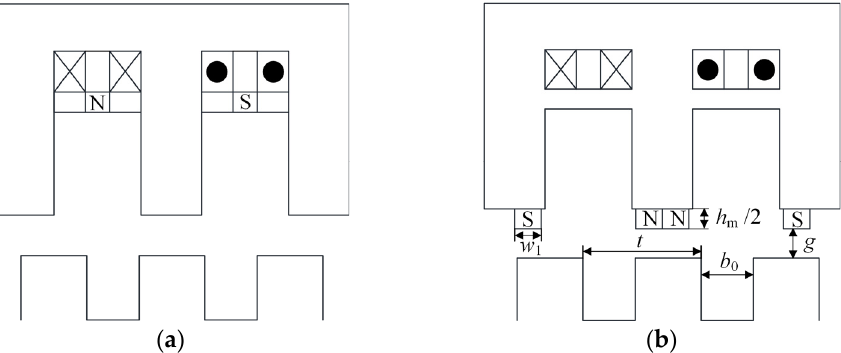
Figure 10. Part structure diagram of the generator: ( a ) original structure; ( b ) equivalent structure.